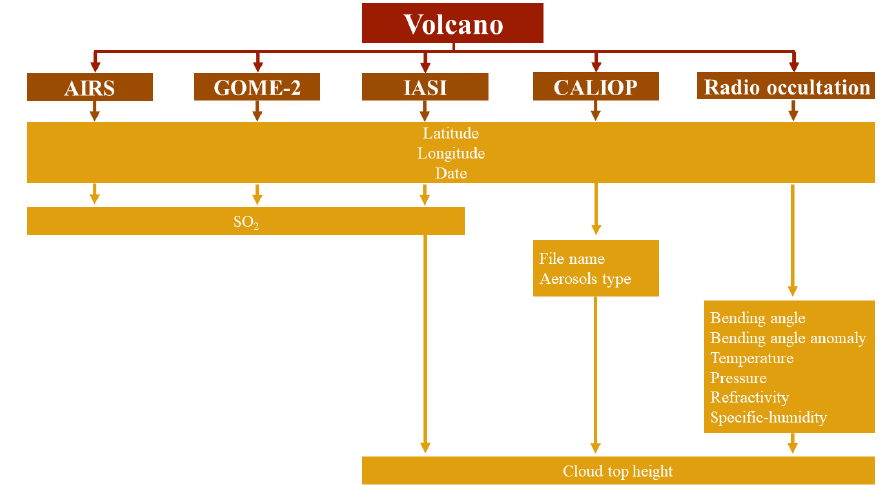
Figure 1. Archive schematic